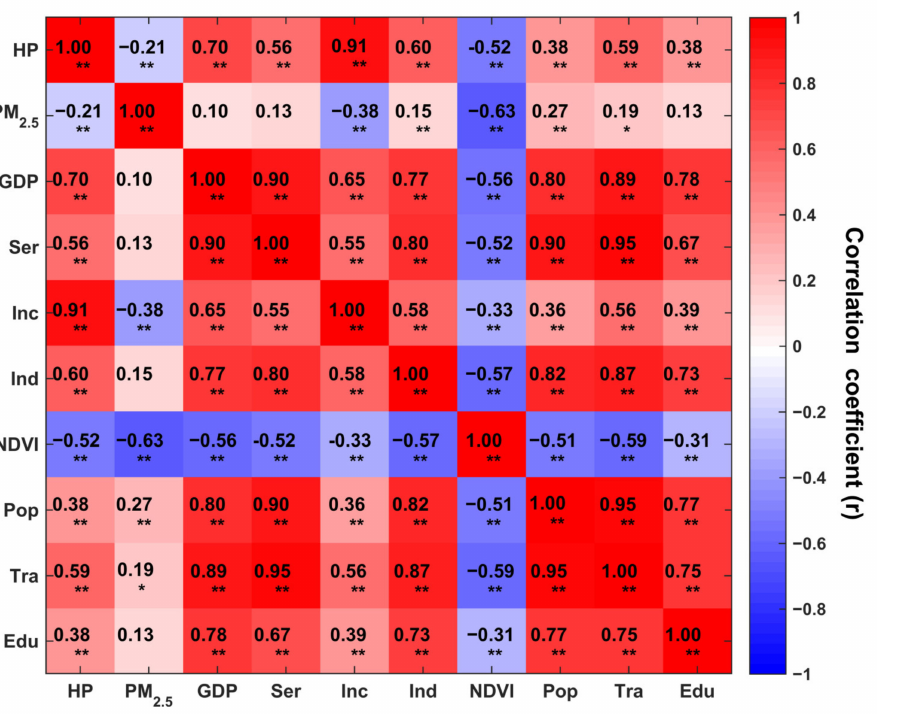
Figure 5. Correlations among house prices, control variables and moderating variables. * and ** indicate significance levels of p less than 0.05 and 0.01,